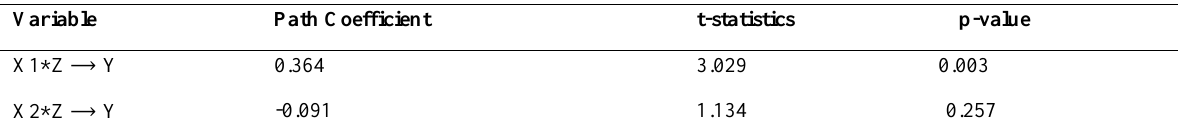
Table 5: Moderation Test